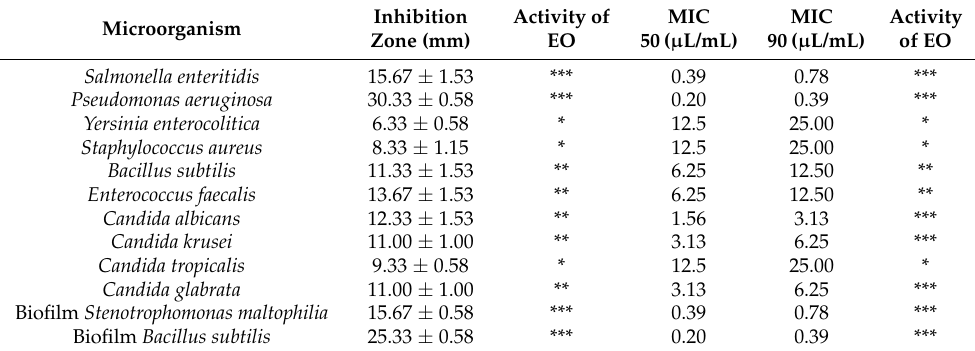
Table 2. Antimicrobial activity of essential oil of T. serpyllum